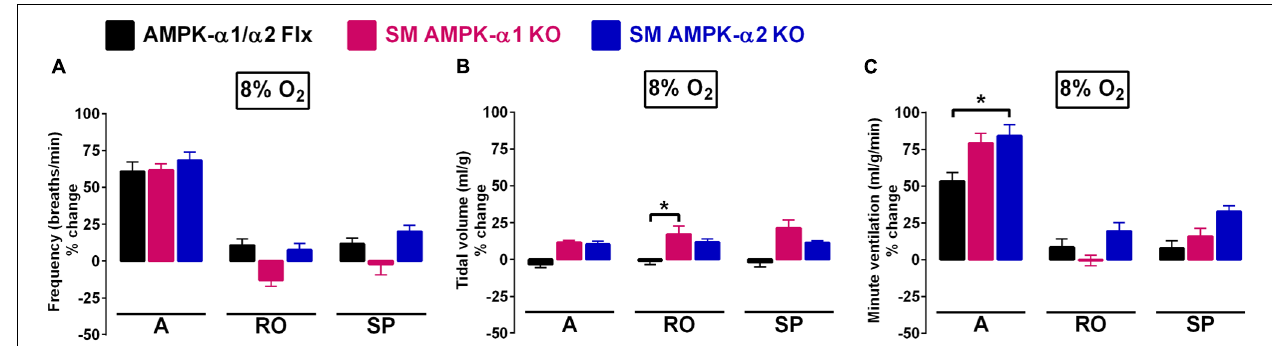
FIGURE 1 | The hypoxic ventilatory response (HVR) is not attenuated by conditional deletion of AMPK- α 1 and AMPK- α 2 subunits in smooth muscles. Bar charts show mean ± SEM for changes in (A) respiratory frequency, (B) tidal volume, and (C) minute ventilation for AMPK- α 1/ α 2 floxed mice (Flx; black, n = 12), and for mice with AMPK- α 1 ( n = 4; magenta) and AMPK- α 2 ( n = 4; blue) deletion in smooth muscles (transgelin expressing cells) during the peak of the Augmenting phase (A), after approximately 100s of Roll Off (RO) and the plateau of the Sustained Phase (SP) of the response to hypoxia; ∗ p < 0.05.